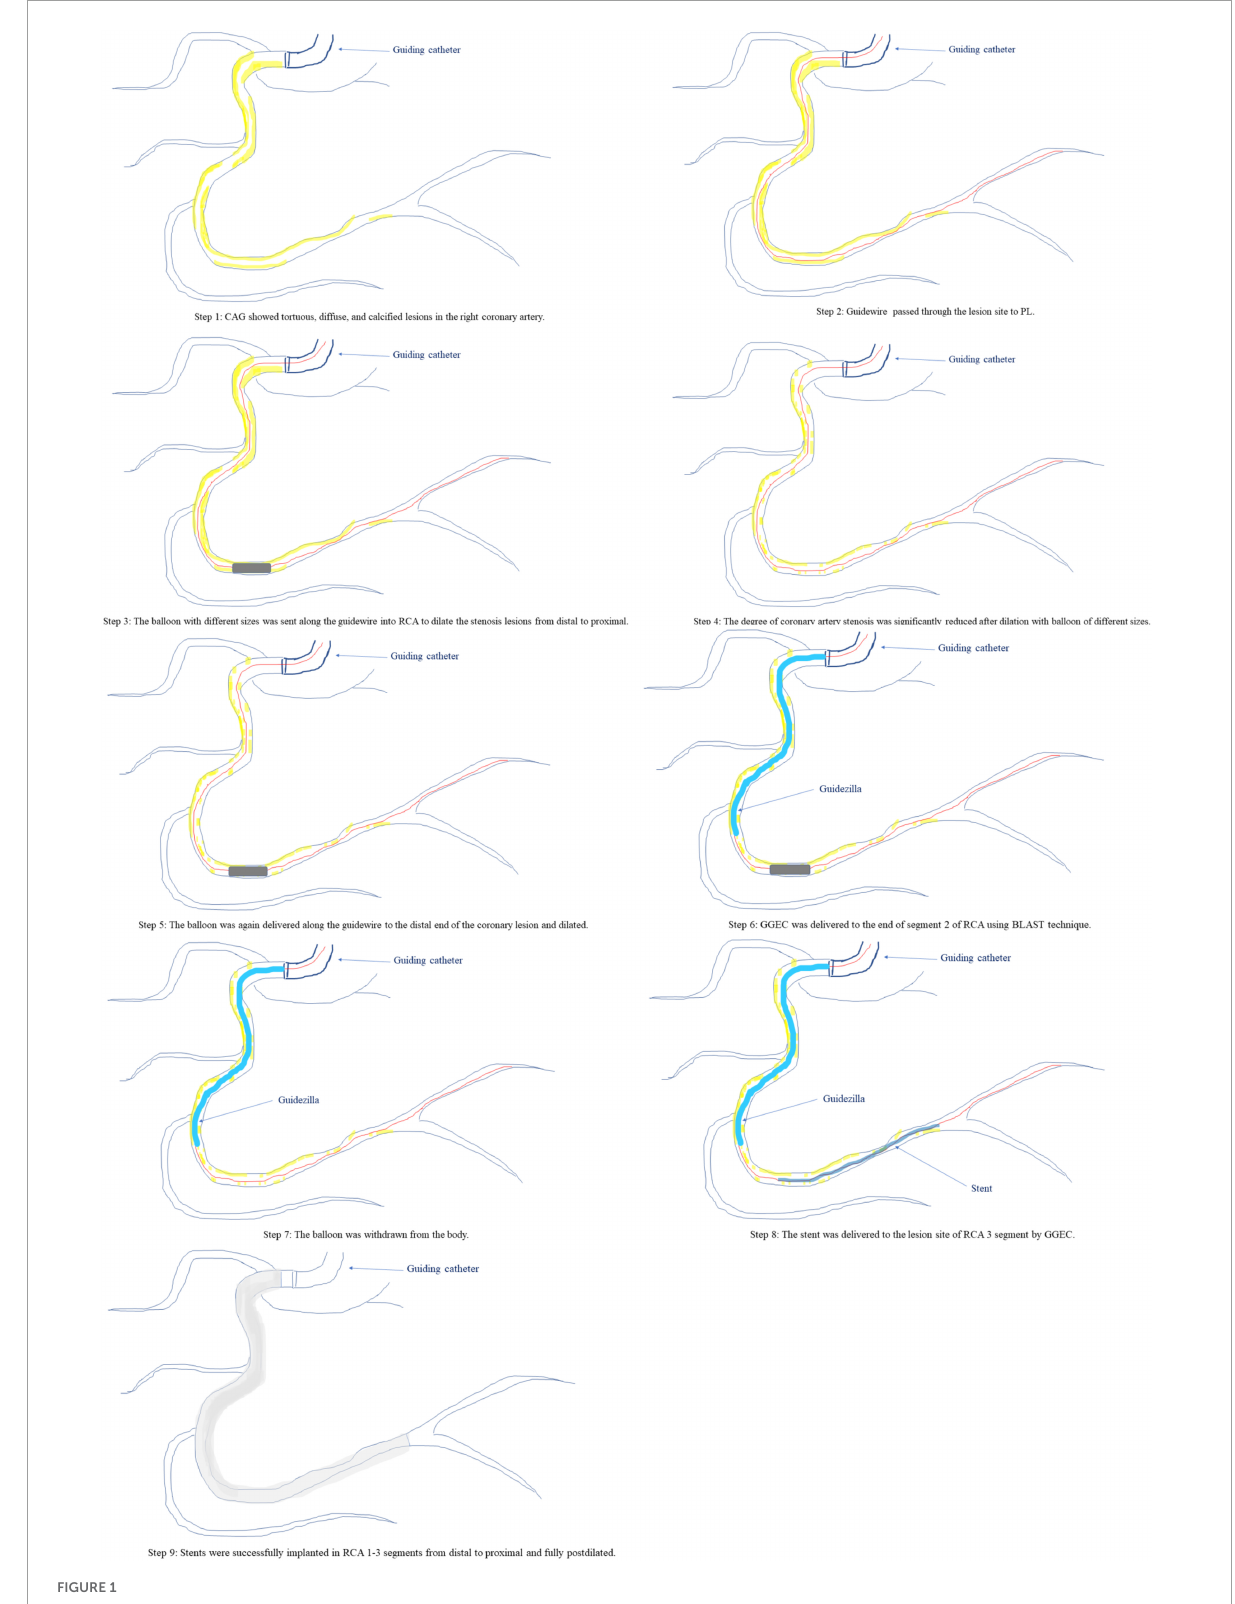
FIGURE1 A schematic diagram of the GGEC I in complex